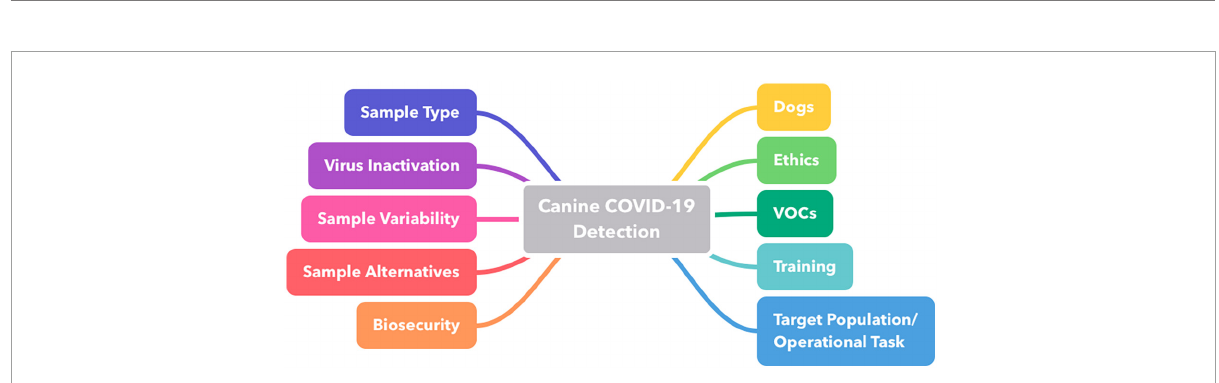
FIGURE1 Mind map representing key areas of interest highlighted and discussed by the group of experts. VOC, volatile organic